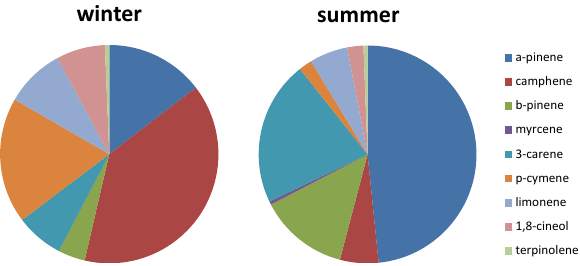
Fig. 2. The monoterpene distribution in winter and in summer at